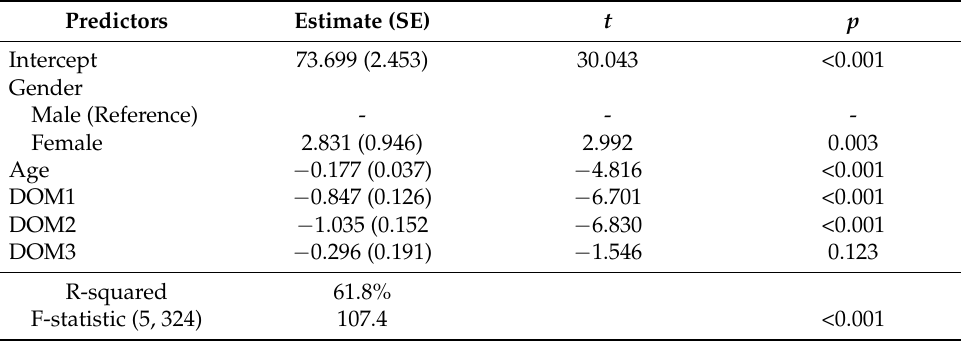
Table 6. Stepwise Linear Regression Model for Depression Symptoms